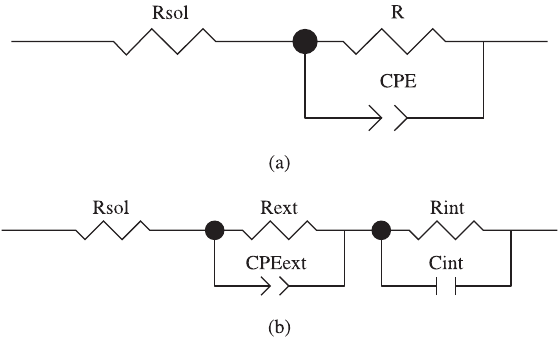
Figure 2. Equivalent electric circuits used to fit the EIS results of MA 956 and PM 2000 alloys.